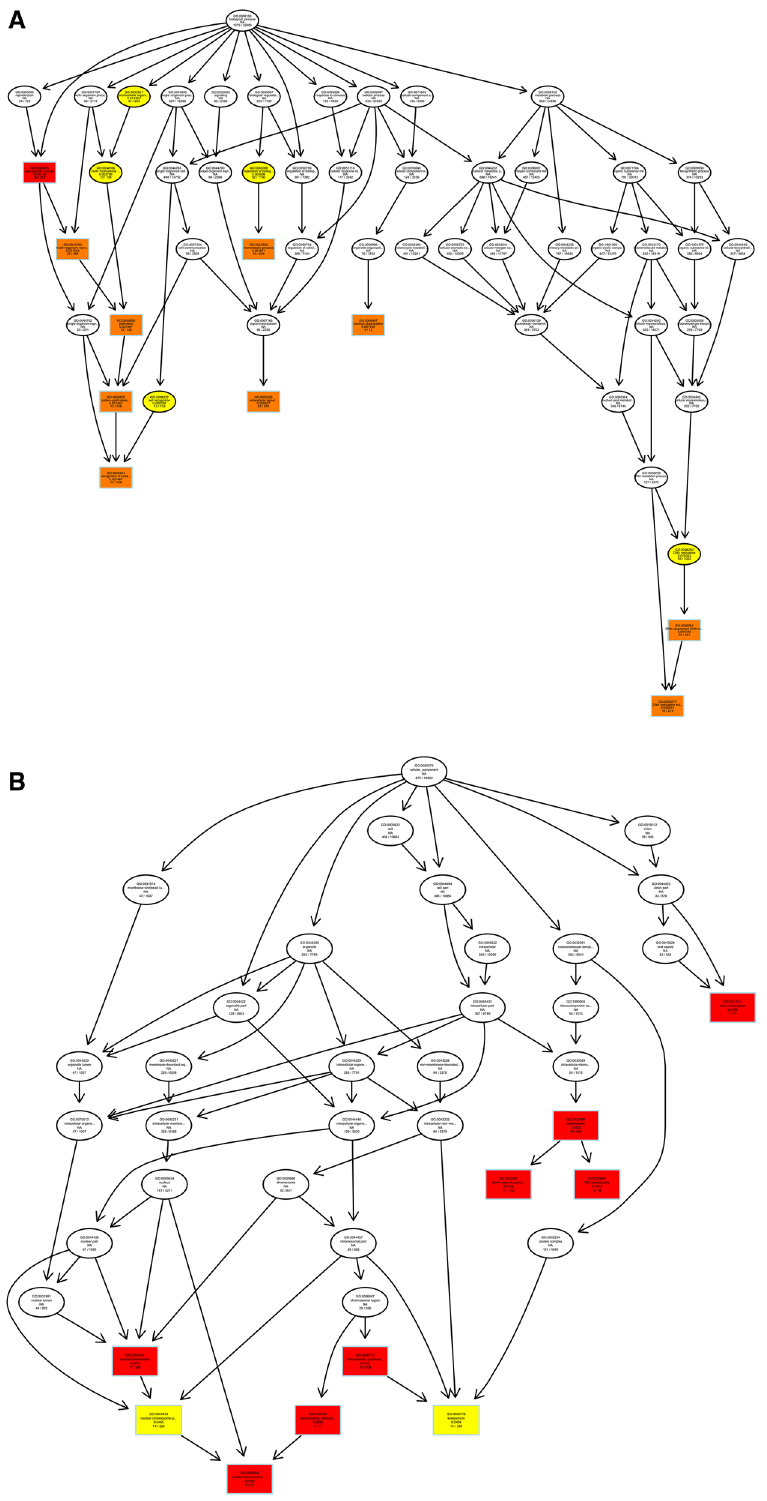
Figure 5. Differentially expressed lncRNAs in ginseng tissues predicted the GO enrichment analysis of target genes according to the co-location. ( A ) The directed acyclic graph of the BP part; ( B ) the directed acyclic graph of the CC part; ( C ) the directed acyclic graph of the MF part; ( D ) statistical histogram. Image generated with R 3.6.3 (https:// www.R- proje ct. org) 51 ggplot2 package (https:// ggplo t2. tidyv erse.